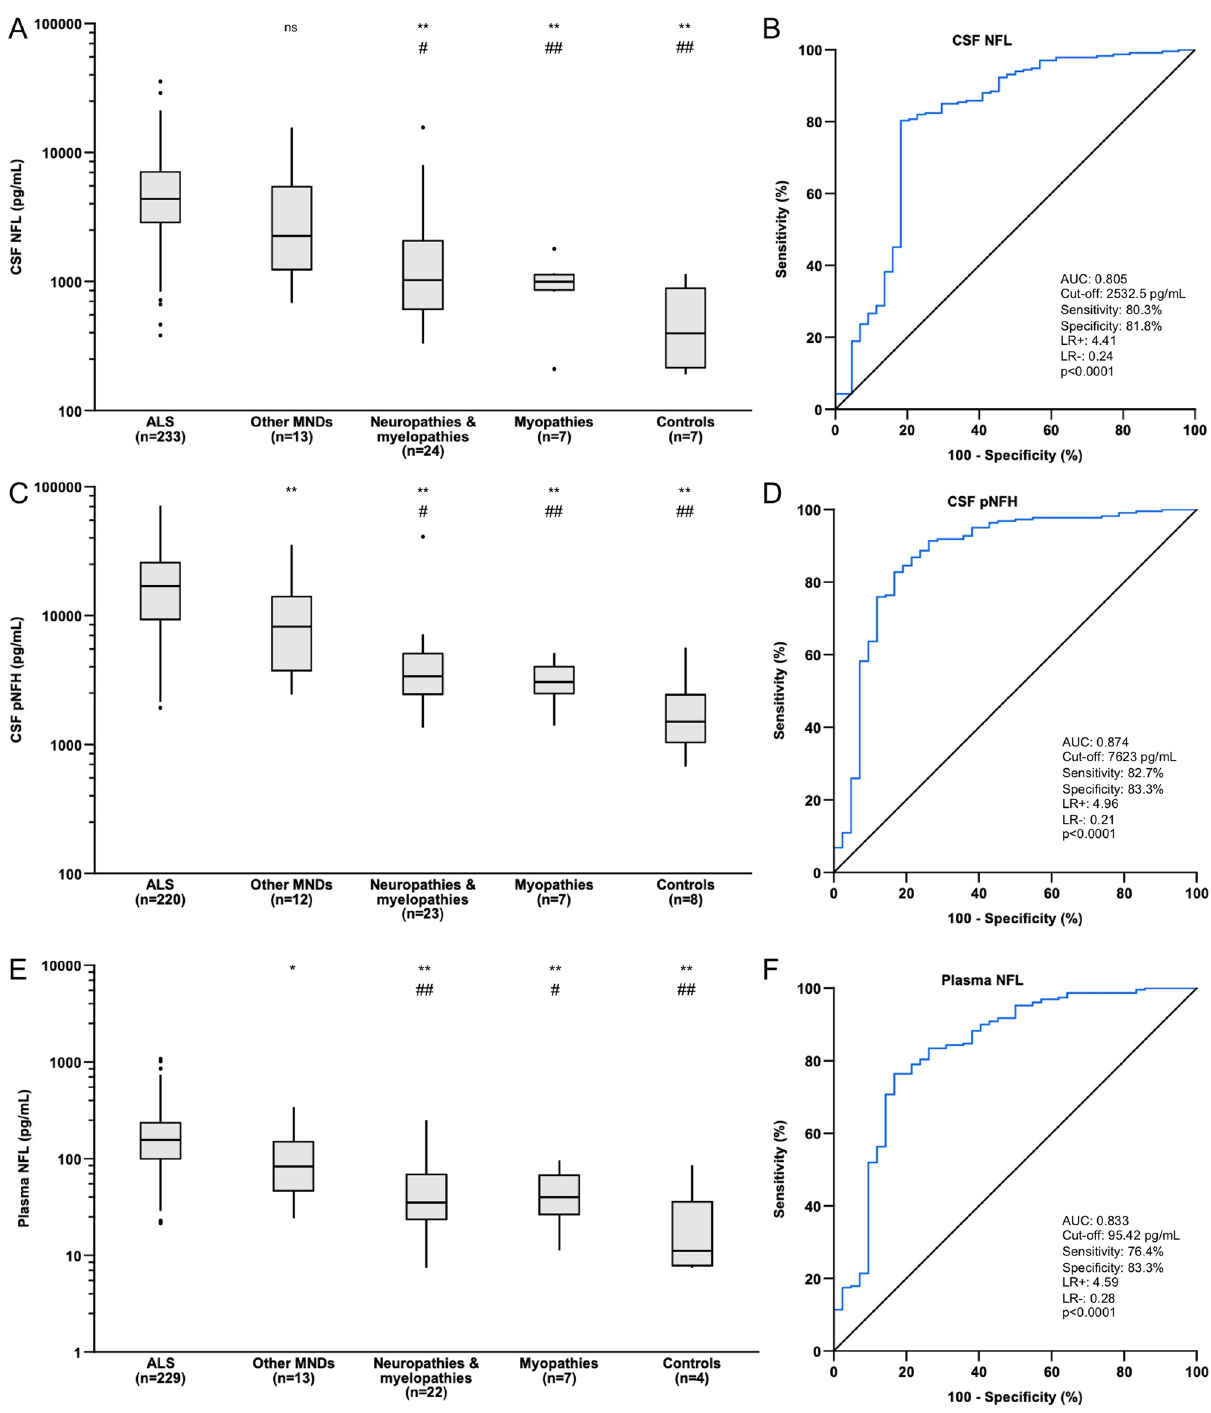
Figure 2. Neurofilament levels and ROC analyses. (A) Boxplots of CSF NFL concentration estimates of participants in the ALS, ALS mimics and control groups. (B) ROC analysis of participants in the ALS versus ALS mimics groups for CSF NFL. (C) Boxplots of CSF pNFH concentration estimates in participants in the ALS, ALS mimics and control groups. (D) ROC analysis of participants in the ALS versus ALS mimics groups for CSF pNFH. (E) Boxplots of plasma NFL concentration estimates of participants in the ALS, ALS mimics and control groups. (F) ROC analysis of participants in the ALS versus ALS mimics groups for plasma NFL. ALS patients versus participants with other MNDs, participants with neuropathies & myelopathies, participants with myopathies and controls: * p < 0.05, ** p < 0.01, ns non-significant. Participants with other MNDs versus participants with neuropathies & myelopathies, participants with myopathies and controls: # p < 0.05, ## p <